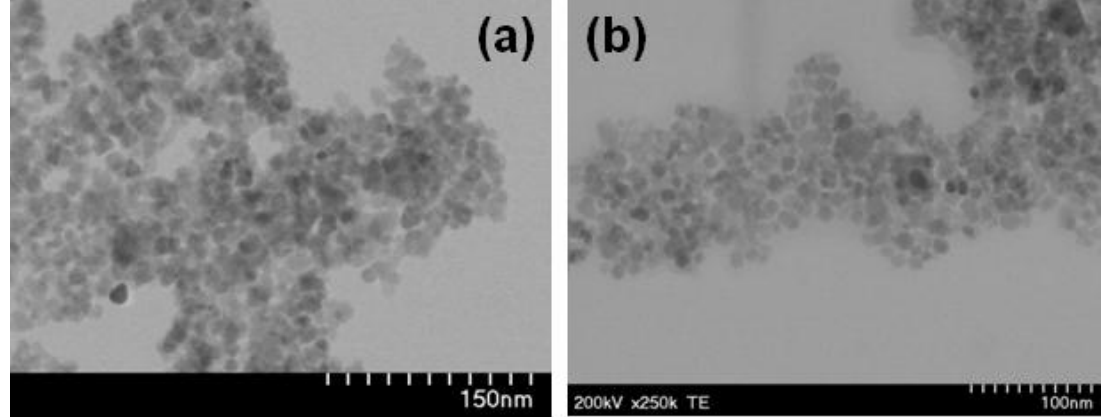
Figure 4. Transmission electron microscopy (TEM) images of magnetic nanoparticles 3a -3 h ( a ) and MNP 2h -3 h ( b ).